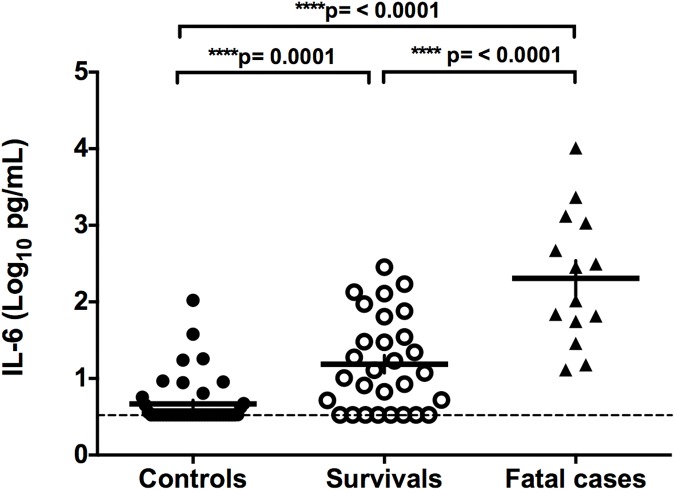
Serum levels of IL-6 in control, HCPS survivals or fatal cases.Circulating levels of IL-6 in serum samples of control individuals and HCPS survivors or fatalities are represented by dots. Values are expressed in Log10 (pg/mL). A Mann-Whitney test for continuous variables was performed to evaluate significant differences between controls individuals and HCPS survivors or fatalities. The ends of the brackets indicate the compared groups. The dashed line represents the lower limit of detection. Each serum sample was analyzed in duplicate in the same plate.